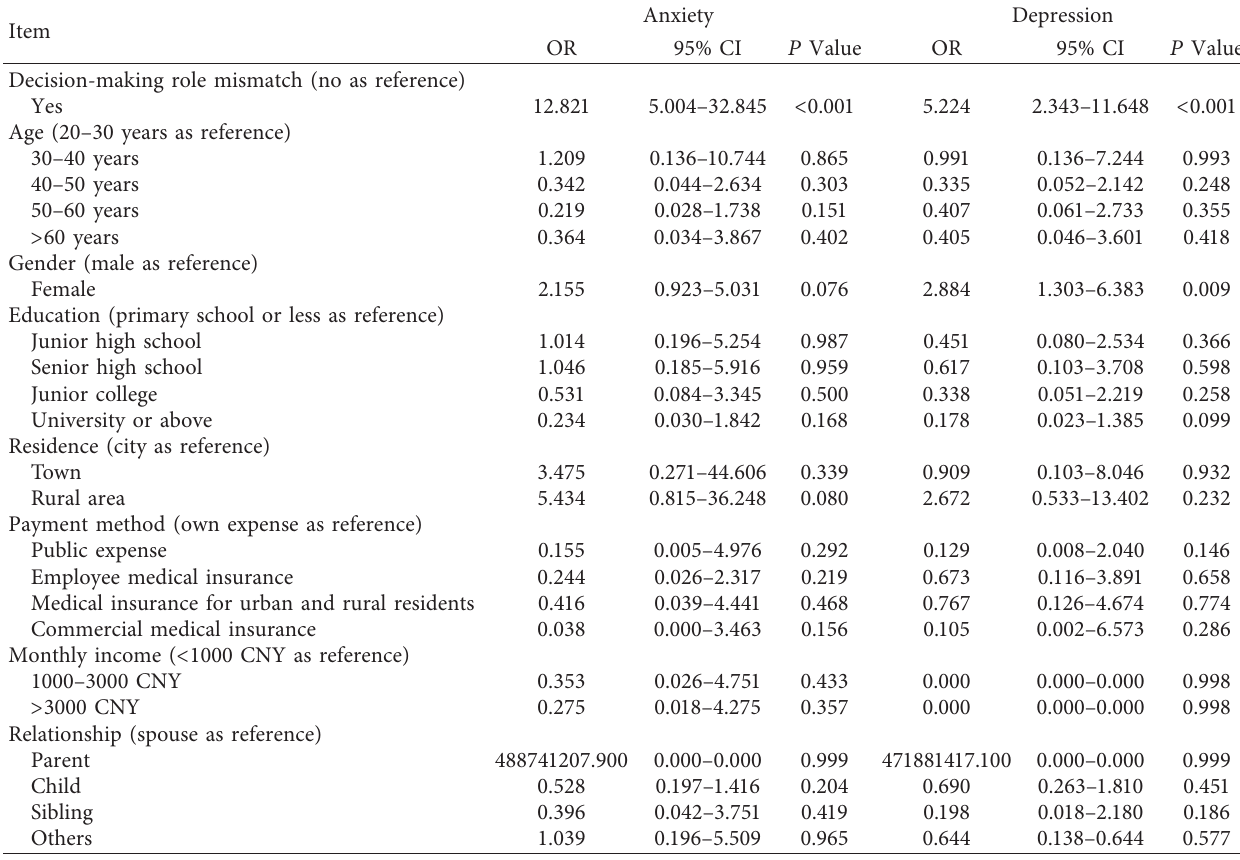
Figure 1: Psychological symptoms of family members were stratified by whether the decision role was matched. Comparing the percentage of role-matched and role-unmatched family members experiencing depression or anxiety symptoms; all P values < 0.001. Table 4: Binary logistic regression analysis of factors affecting anxiety and depression in ICU patient family